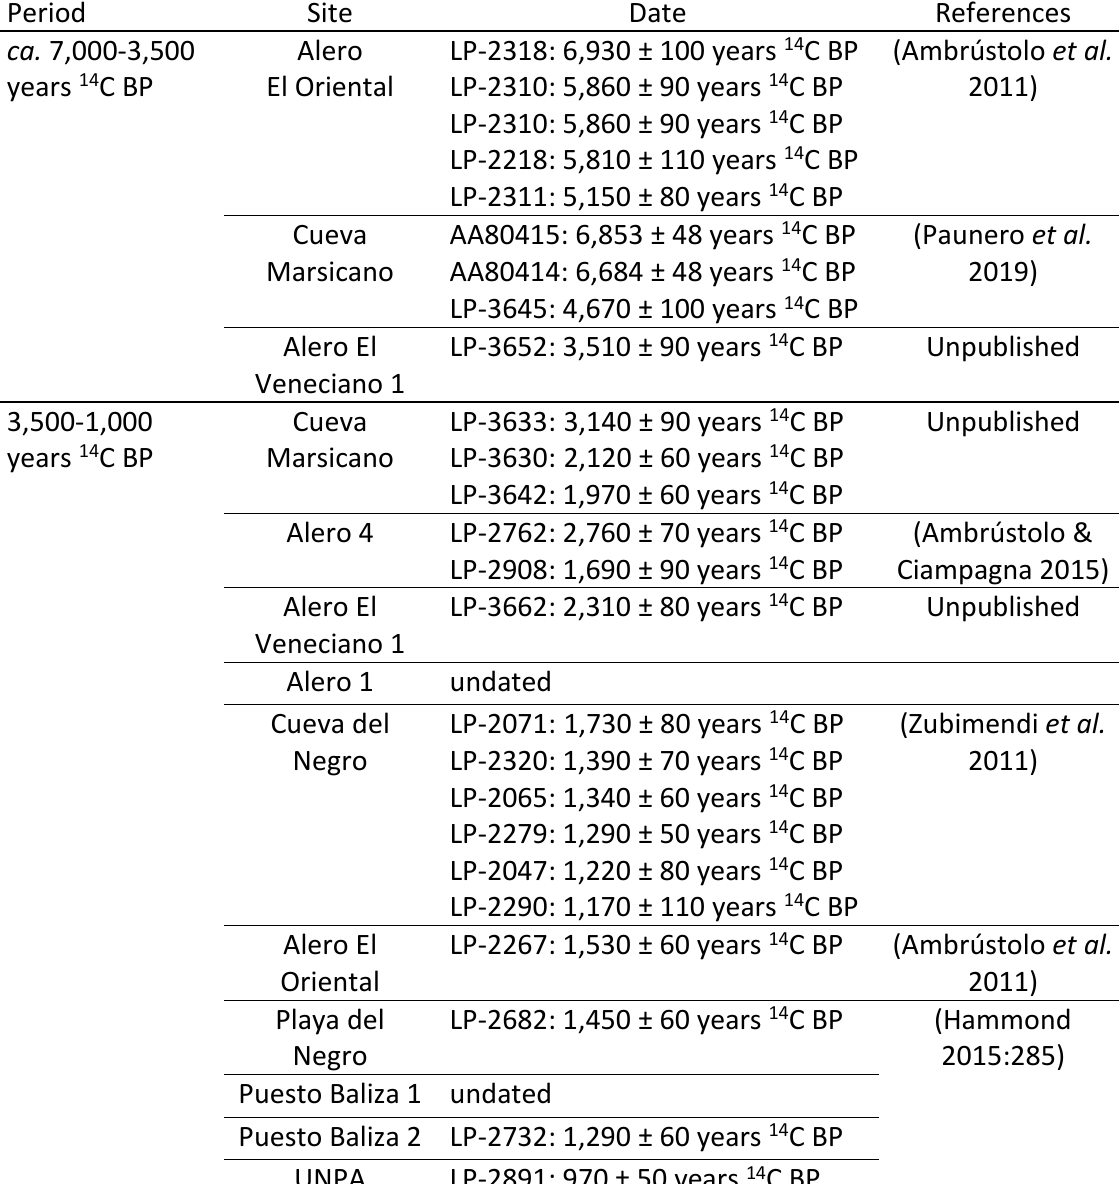
Table 1. 14 C dates of analysed